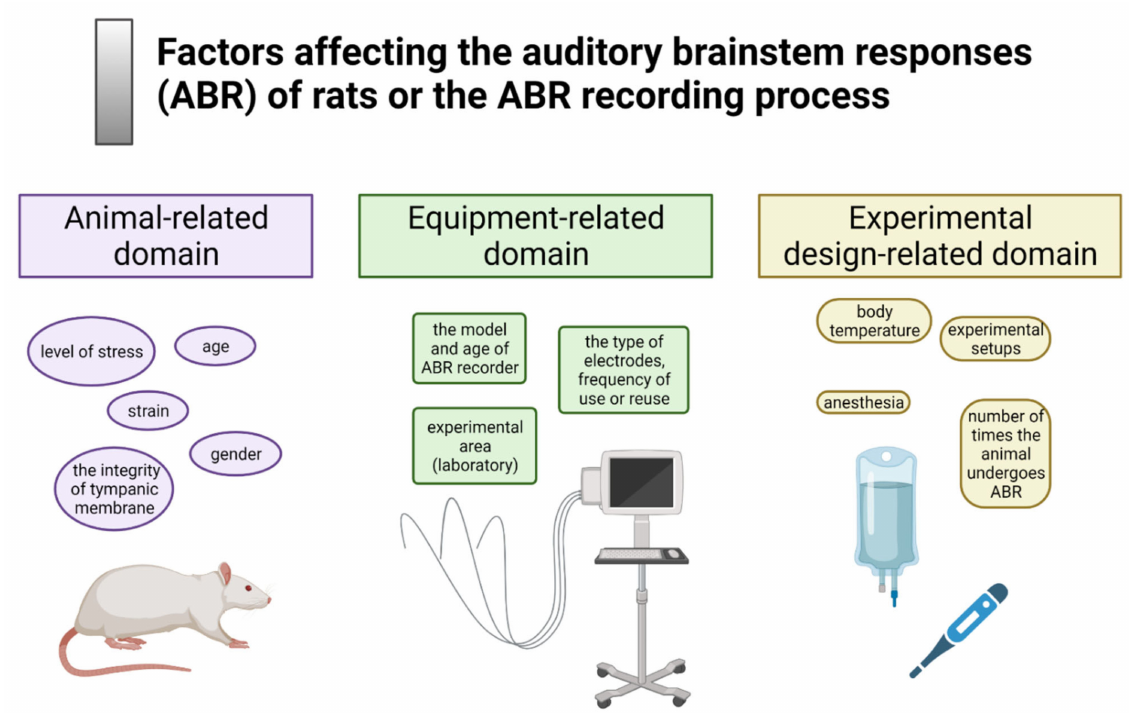
Figure 4. The survey examined three domains reflecting animal-, equipment-, and experiment-dependent factors influencing the ABR outcome. Created with BioRender.com (accessed on 28 November